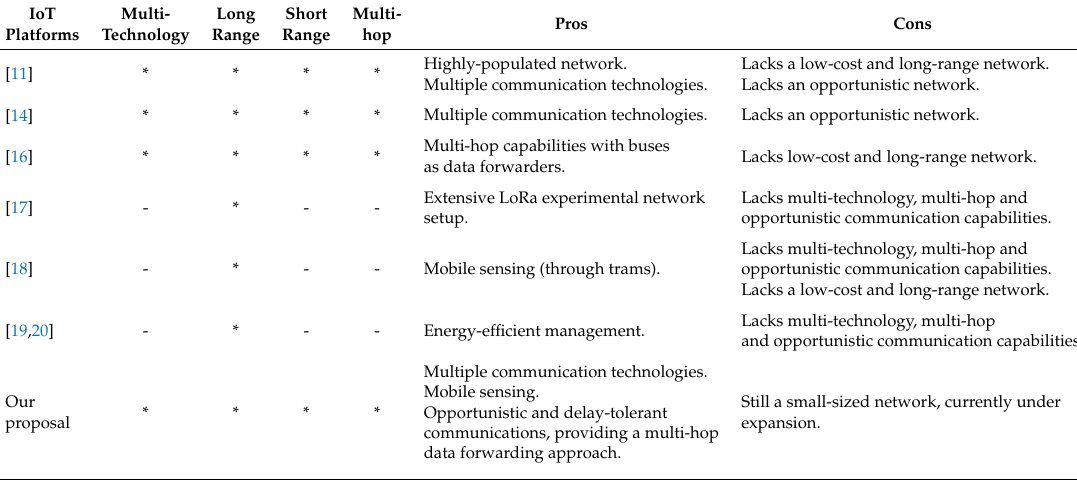
Table 1. An overview of IoT platforms for smart